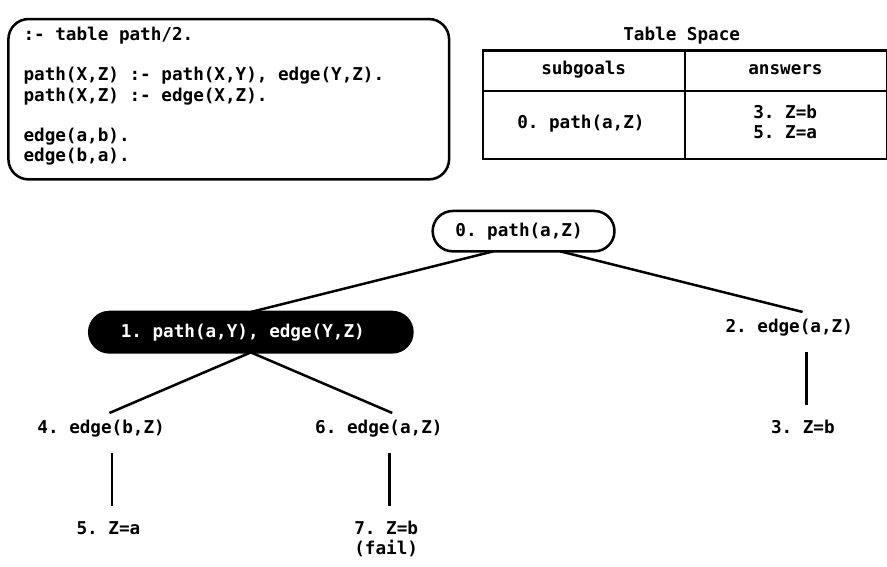
Figure 2. An example of a tabled